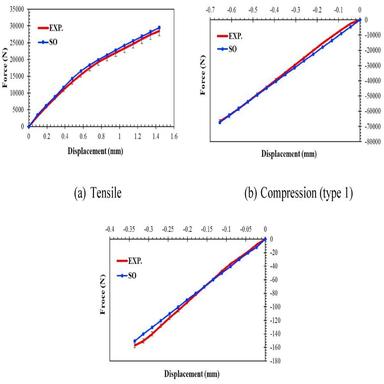
Comparisons with the results of the inverse identification analysis (Class 1).